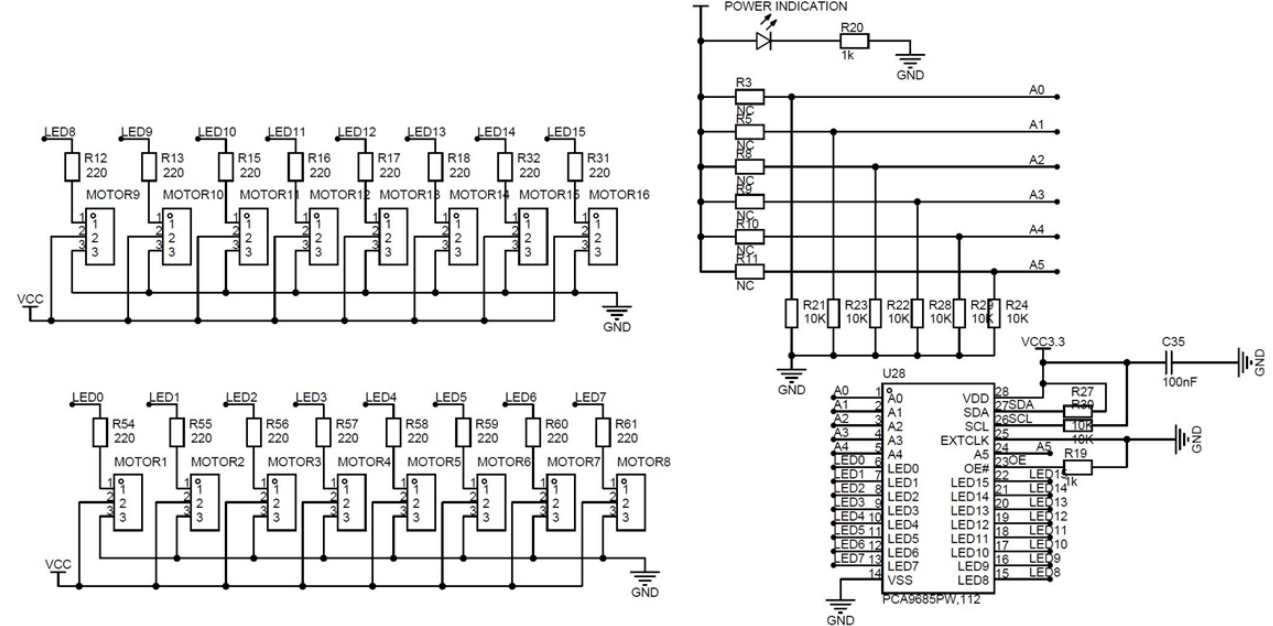
Figure 11. Drive control system circuit design drawing.